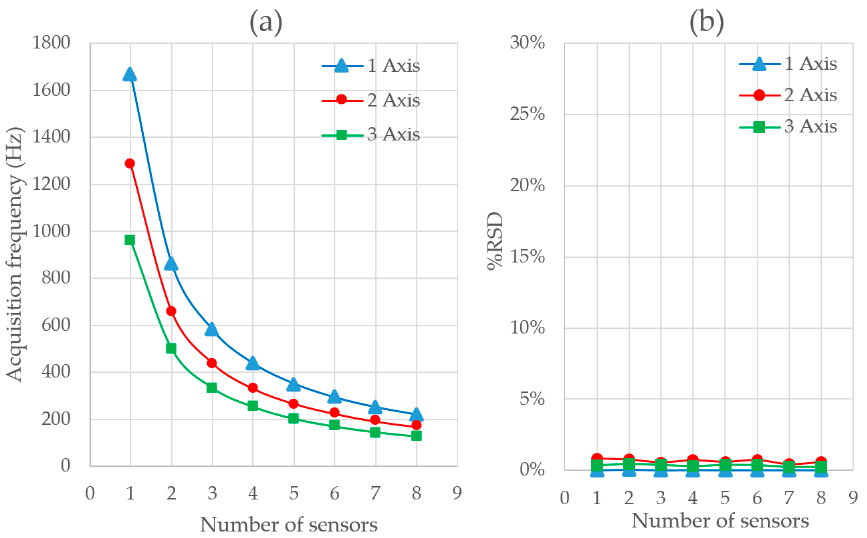
Figure 7. ( a ) Acquisition frequency depending on the number of sensors and axis read at the same time with Serial.print method and ( b ) acquisition frequency relative standard deviation (RSD) depending on the number of sensors and axis read with Serial.print method.